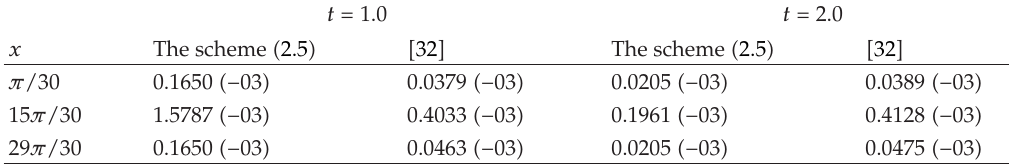
Table 7: Absolute errors of scheme (cid:3) 2.5 (cid:4) and the scheme in (cid:6) 32 (cid:7) (cid:3) h (cid:9) π/ 300 , τ (cid:9) 0 . 1 (cid:4) . t (cid:9) 1 . 0